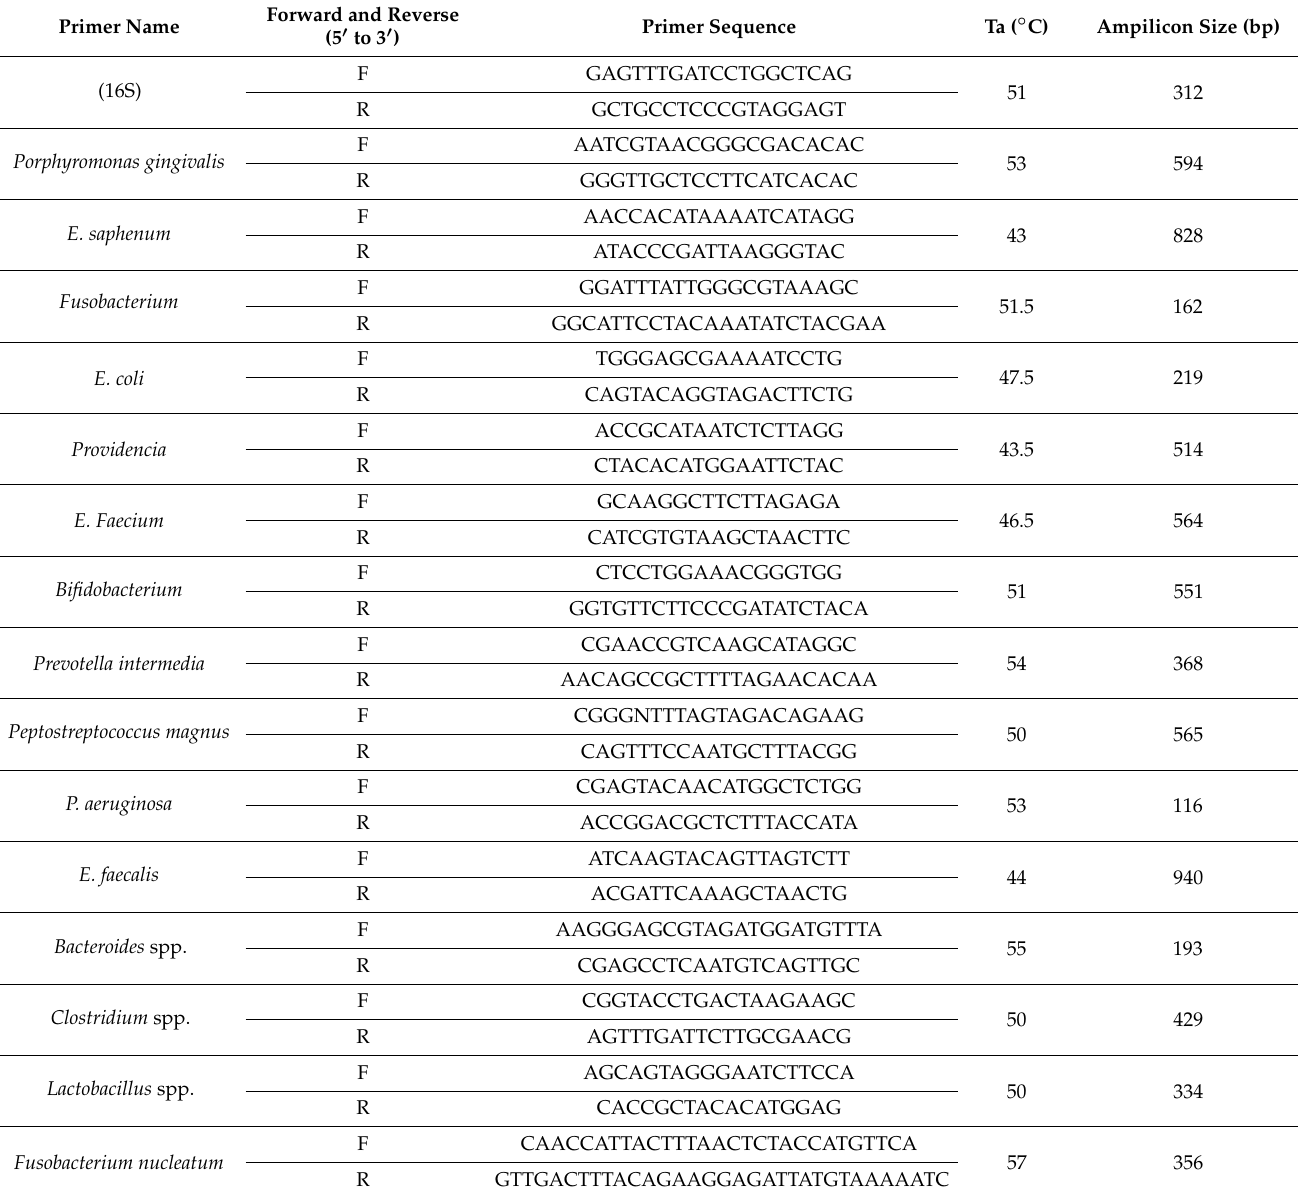
Table 4. Primer sequences for the detection of different species of